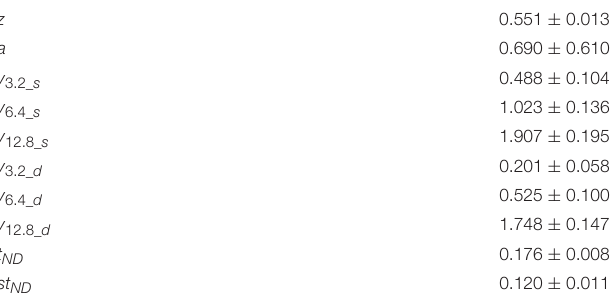
TABLE 2 | Fitted parameters (mean ± SE) of the second DDM (model v ).